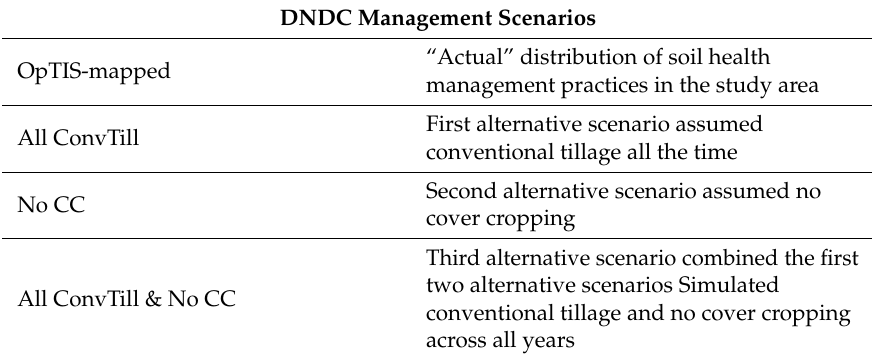
Table 2. Four scenarios run to simulate e ff ects of OpTIS-mapped management to less-optimal soil health management. Model simulations were simulated by county and proceeded as